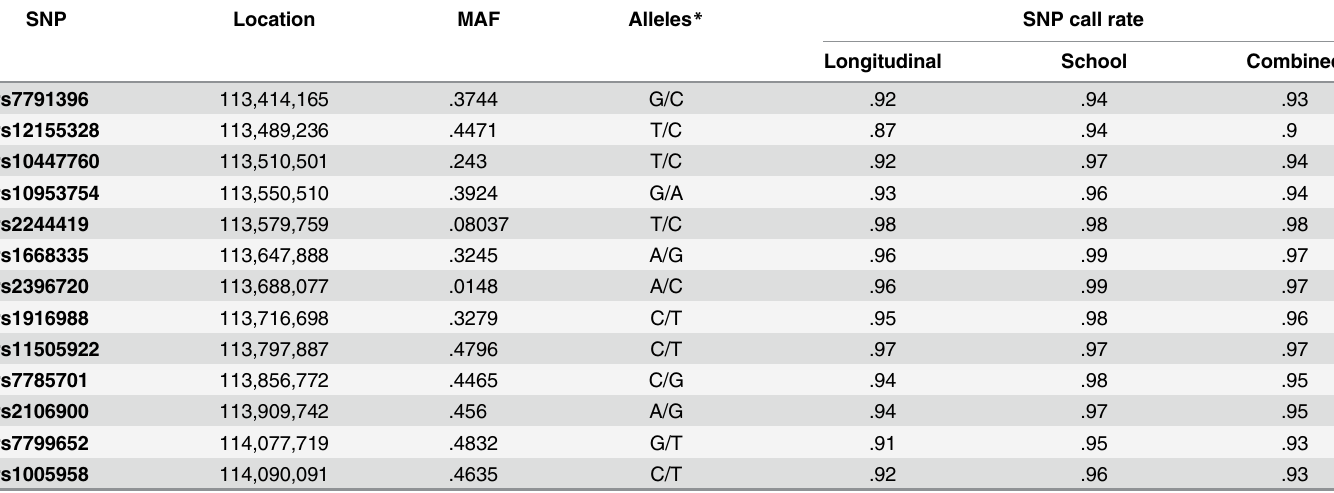
* The A1 allele is the minor allele. Base-pair location is based on the National Center for Biotechnology Institute db SNP Build 131 of the human genome (NCBI dbSNP